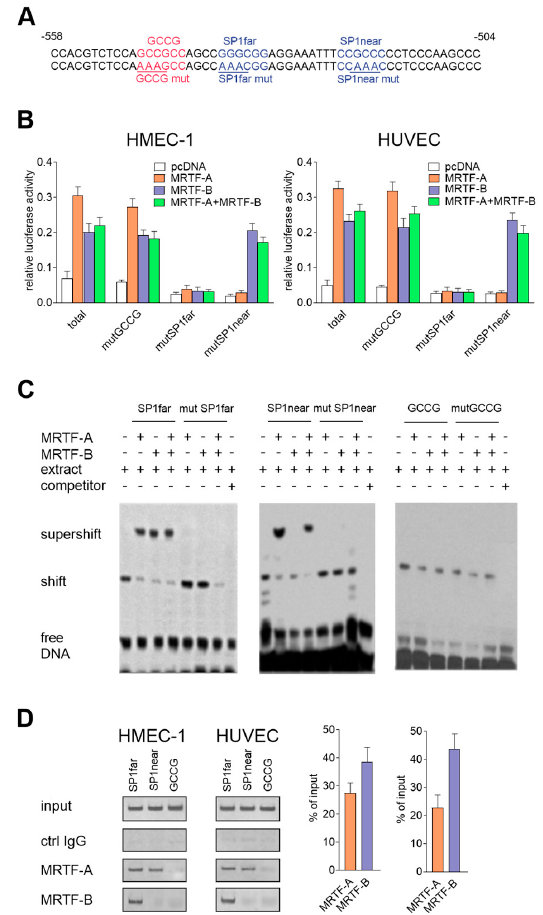
Figure 6. Role of the SP1 motifs in MRTFs-dependent snail expression regulation. ( A ) Sequences of mutated GCCG- and SP1-binding